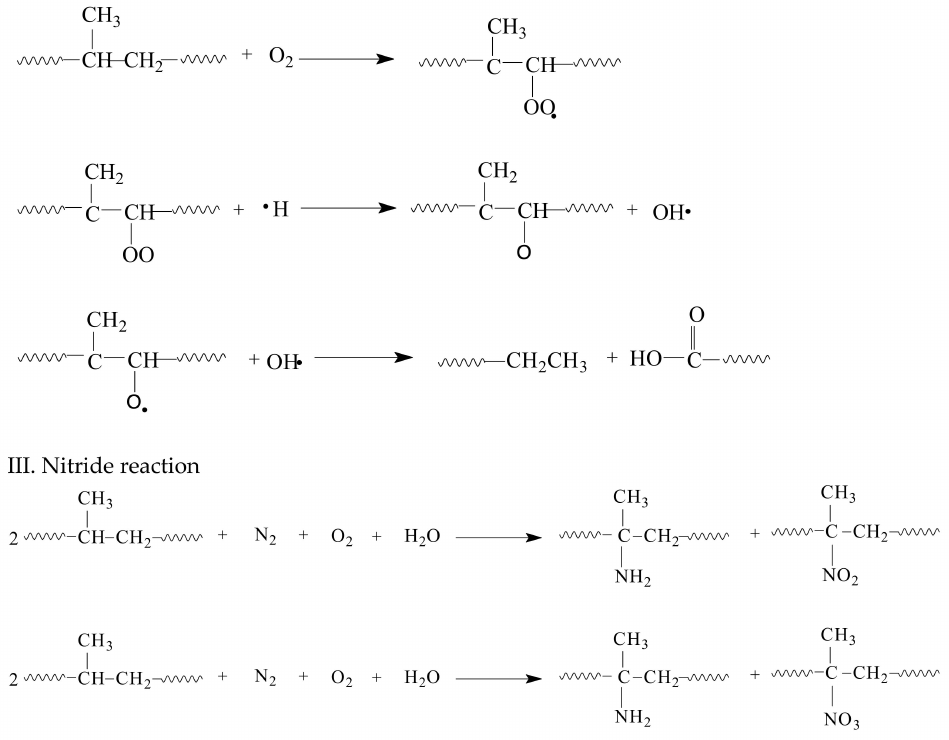
Scheme 2. The involved chemical reactions of BOPP film during corona discharge treatment.